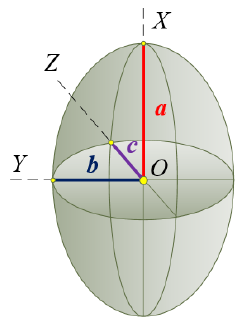
Figure 1. The Scots pine seed shape used in the study. a , b , and c are semi-axes of the ellipsoid, located along the X-, Y-, and Z-axes from three-dimensional coordinate system,